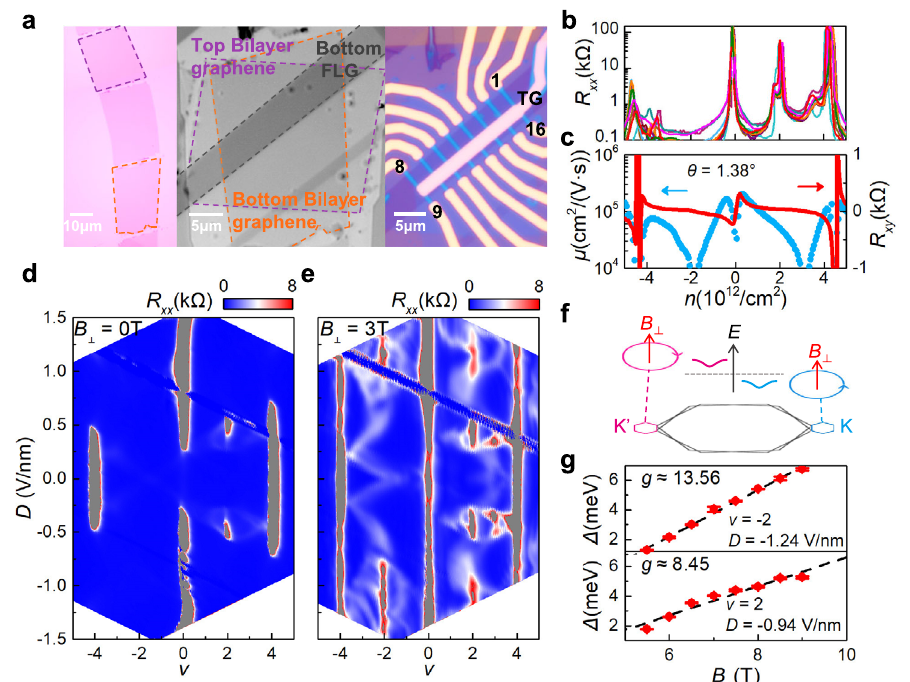
Fig. 1 Valley polarized correlated insulating states in AB-BA TDBG. a Optical microscope images of the fabrication process of device D1( θ = 1. 38°). The bilayer graphene, ABBA-TDBG and the dual-gate device are presented in turn from left to right. The bottom gate is few layers graphite (FLG) and the top gate (TG) is Ti/Au. The scale bar is shown in fi gure. b Four-terminal longitudinal resistance versus carrier density n at D = − 0.46 V/nm between every two adjacent bars from 1 to 16. c Hall mobility and Hall resistance versus carrier density at D = 0 V/nm. d , e Longitudinal resistance R xx as a function of fi lling factor v and displacement fi eld D in device D1. Left and right fi gures correspond to the transport data measured at B ⊥ = 0 T and B ⊥ = 3 T, respectively. f Schematic of the valley polarization. The blue and pink circles represent the orbital magnetization of K and K ’ valley, respectively. Different direction of arrows indicates the orbital magnetizations of two valleys are opposite. The blue and pink curves correspond to the valley polarized energy band induced by the orbital Zeeman effect under the perpendicular magnetic fi eld. g Thermal activation gaps versus perpendicular magnetic fi elds. The top fi gure shows the energy gap at v = − 2 and D = − 1.24 V/nm, and the bottom fi gure shows the energy gap at v = 2 and D = − 0.94 V/nm. Error bars are estimated according to the uncertainty at the thermal activation